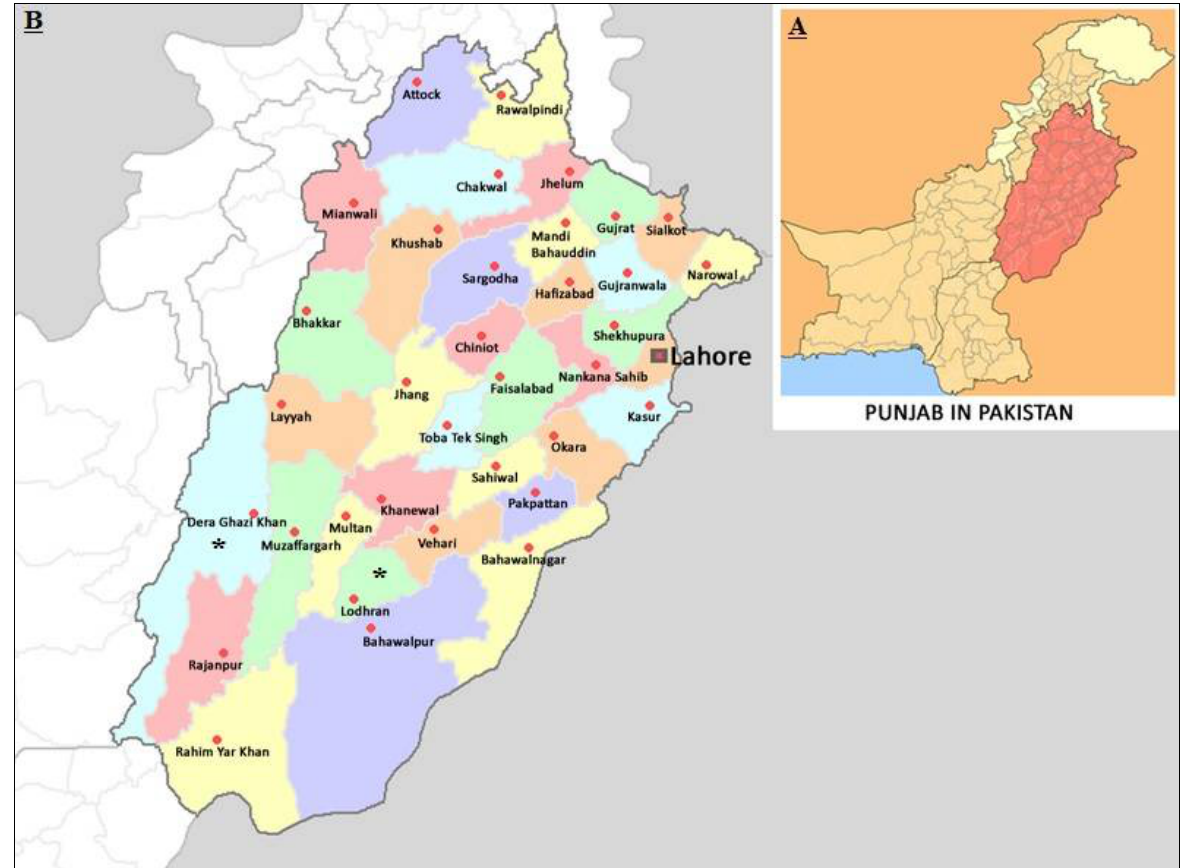
Figure 1. ( A ) Map of Pakistan with Punjab province highlighted. ( B ) Districts Lodhran and Dera Ghazi Khan, from where cattle blood samples were collected, are marked with * in the magnified section.